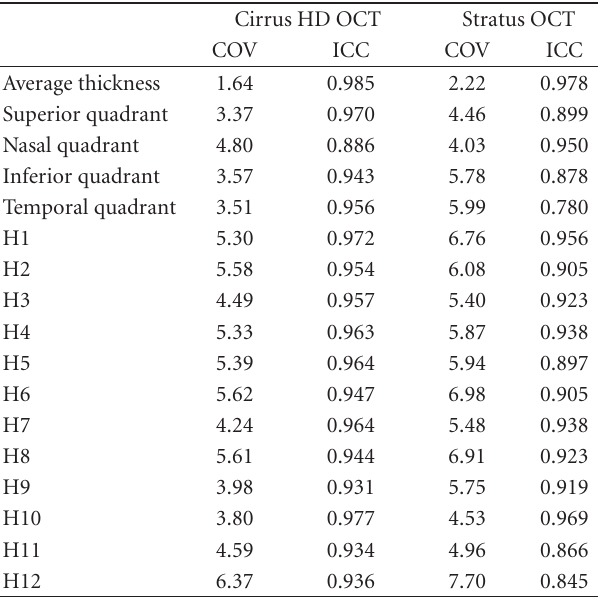
Table 2: Coe ffi cients of variation (COVs) and intraclass coe ffi cients (ICCs) for repeated retinal nerve fiber layer thickness measurements using Cirrus HD and Stratus optical coherence